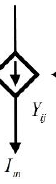
Figure 6. Voltage-controlled current source.